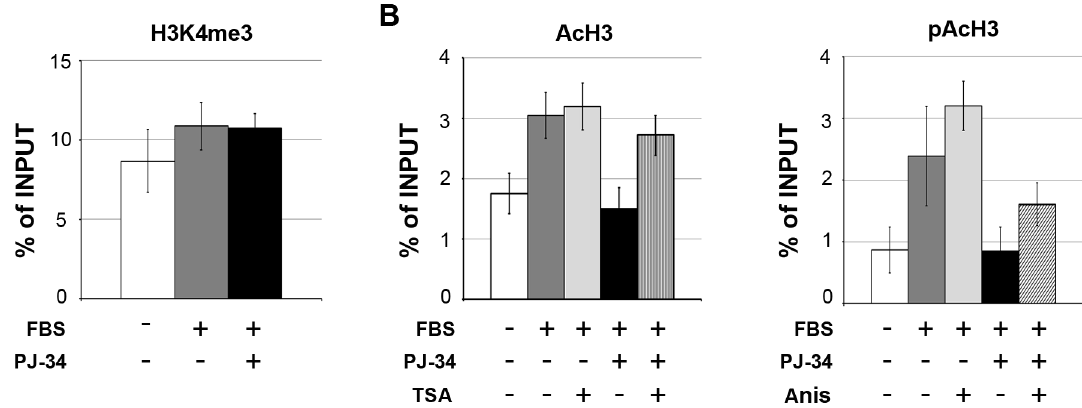
Figure 5. PARP-activity is required for histone modifications at c-MYC promoter. A, Histone H3K4me3 levels at c-MYC promoter assessed by ChIP-qPCR. Chromatin samples were obtained from quiescent (-FBS) or 30 minutes serum-stimulated ( + FBS) fibroblasts treated or not with PJ-34, and immuno-precipitated with an antibody specific for H3K4me3. Values relative to the occupancy of c-MYC promoter (fragment fr.2 + 3) were normalized respect to those of GAPDH promoter and expressed as percentages of Input chromatin. The results shown are representative of two independent experiments and the error bars represent the SD of three technical replicates. B, Acetyl histone H3 (AcH3) and phosphoacetyl histone H3 (pAcH3) levels at c-MYC promoter assessed by ChIP-qPCR. Quiescent fibroblasts were pre-treated with TSA or Anisomycin (Anis) then serum- stimulated for 30 minutes in the presence or absence of PJ-34. Chromatin samples were immuno-precipitated with antibodies specific for AcH3 or pAcH3. The reported values are expressed as in A.